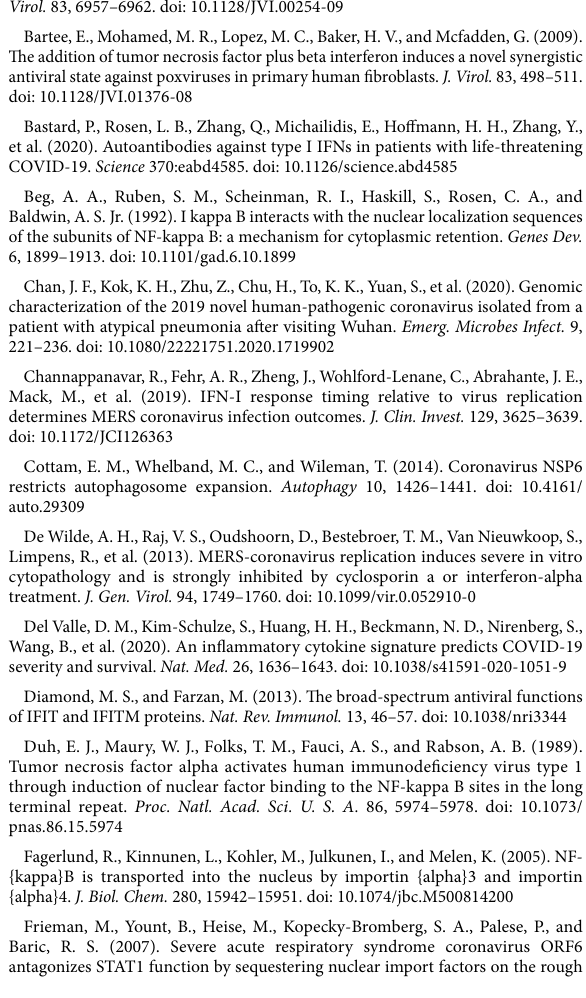
SUPPLEMENTARY FIGURE S1 The expression of SARS-CoV-2 non-structure proteins in the reporter gene assay. Aliquots of cell lysates collected from Figure 1A were analyzed by immuno-blotting with anti-FLAG and anti-alpha-tubulin antibodies. The expression of viral proteins are indicated by red arrows. The positions of molecular mass markers in kDa are indicated on the